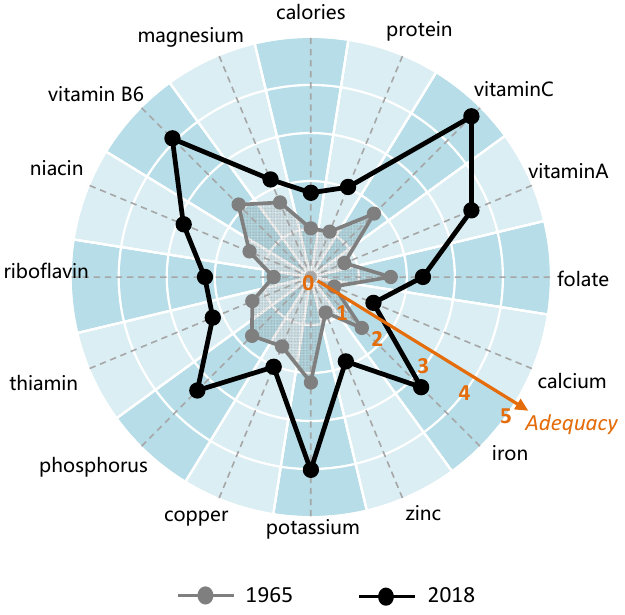
Figure 3. The supply adequacy of different nutrients in food supply of Chinese residents in 1965 and 2018 .